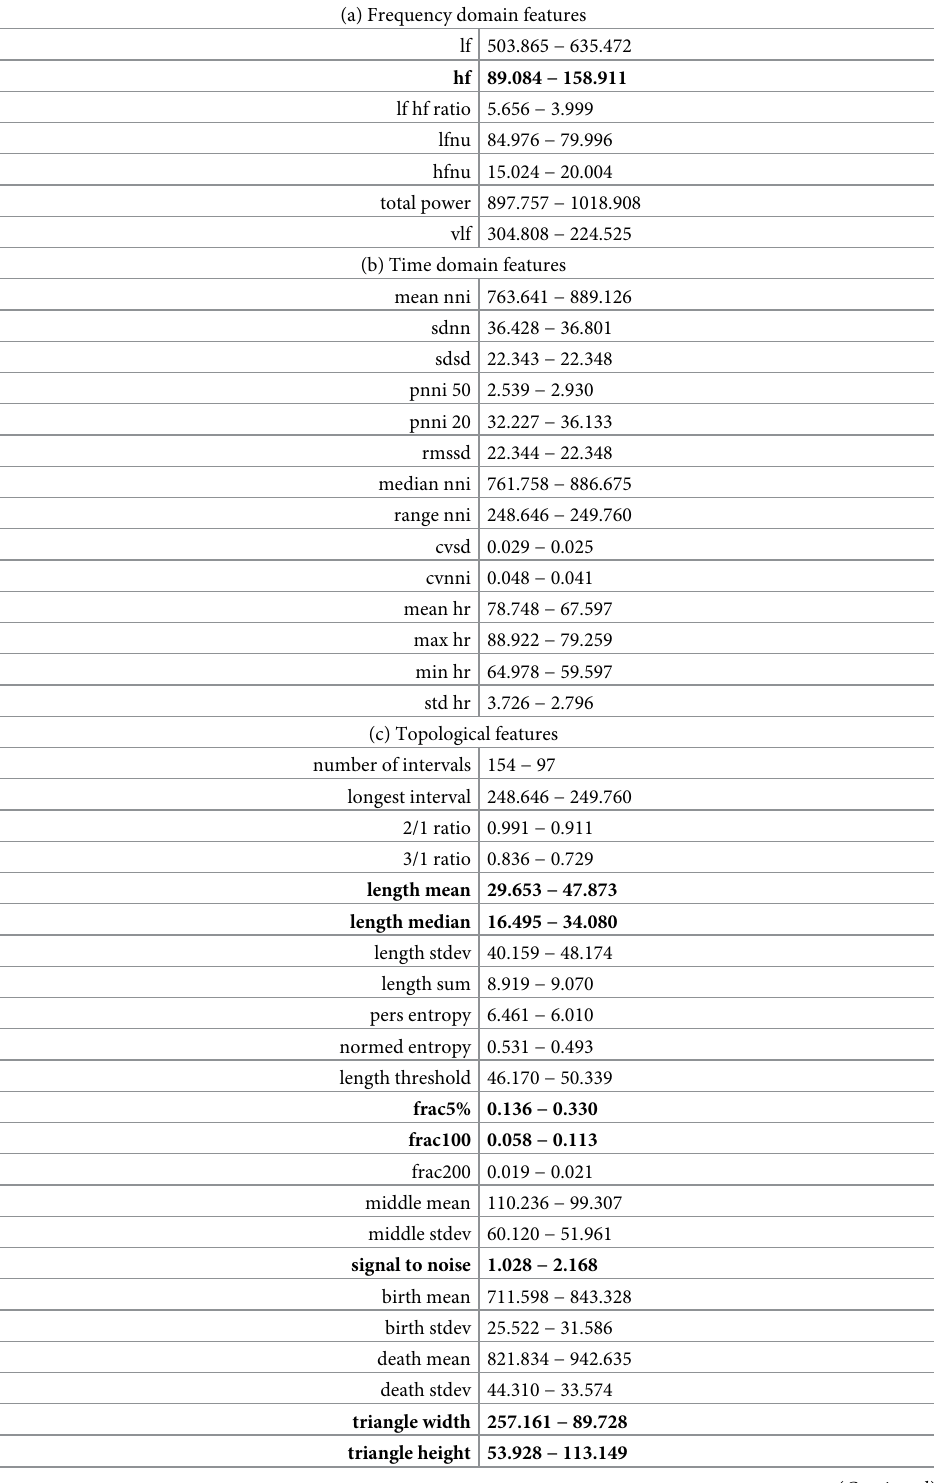
Table 2. Comparison of values of all the considered standard and topological hrv parameters in a patient with the acute ischemic stroke (STR, male, 56 years, left-hand side) and a healthy person (CON, male, 55 years, right-hand side). Ten features that exhibit the highest relative differences are shown in bold typeface. See text for